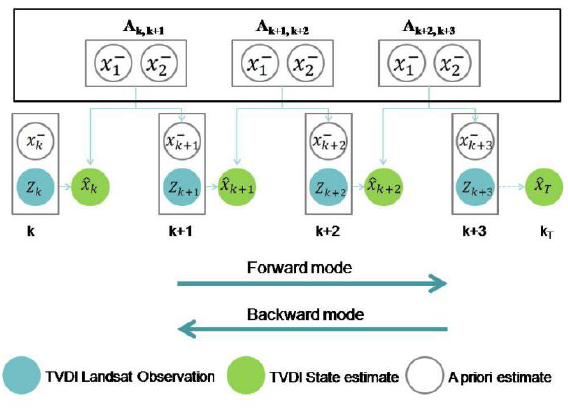
Figure 1. Flow chart of the Kalman filter approach Figure 1 shows the process of Kalman filter algorithm for generating time series TVDI data. The transition model A projected the estimate from a previous state (time update). The priori estimate was produced by the combination of 𝑋 ― 𝑘 submodels 1 and 2, , respectively. If a Landsat 𝑋 ― 𝑘2 , 𝑋 ― 𝑘1 observation is available, provides a new estimate 𝑍 𝑘 (measurement update). is the final estimate which is the 𝑥 𝑘 weighted average of and , If not available, the estimate 𝑥 ― 𝑘 𝑍